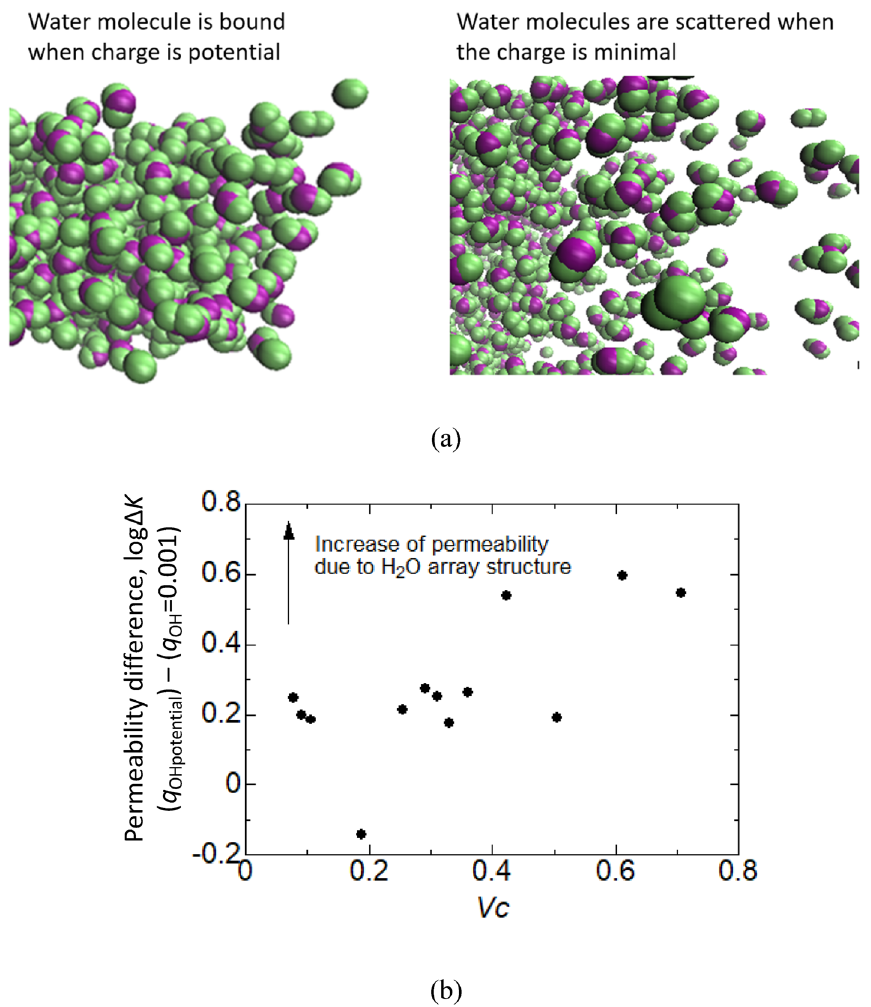
Figure 4. Effect of the arrangement structure of water molecules. ( a ) Image of water molecule structure with potential and 0.001 charges. The figure is created by VMD (version: 1.9.3, https ://www.ks.uiuc.edu/Resea rch/vmd/). ( b ) Permeability difference when the electric charge was 0.001 and the potential charge of water